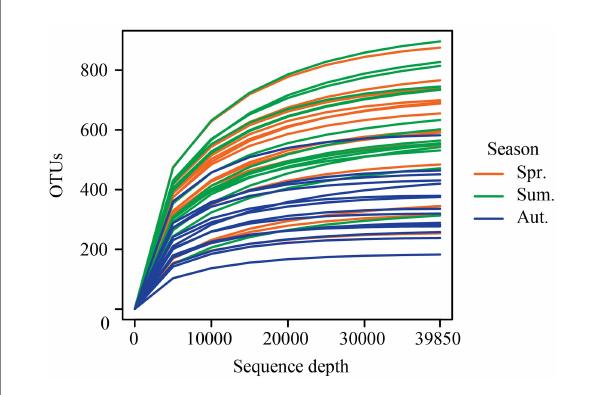
FIGURE 2 The rarefaction curves of the sequence depth and the number of OTUs from 45